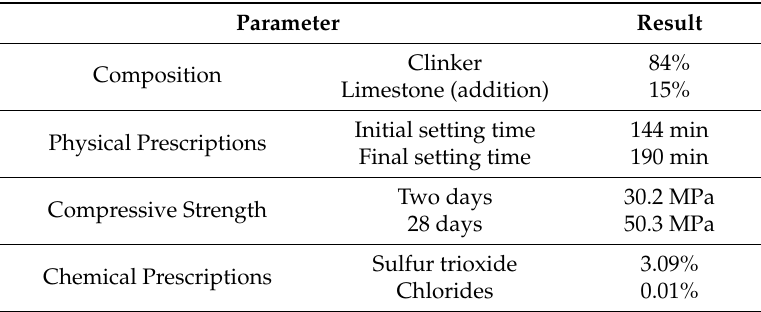
Table 1. Physical and chemical properties of